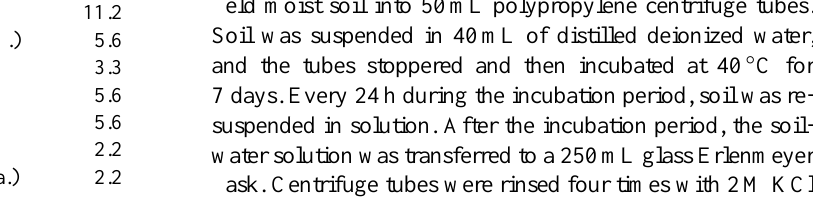
Table 2. Species and rate of application of ground cover hy- droseeded in 2008 at the Arch–Birch River mine in Webster County, West Virginia. Species Rate Birdsfoot trefoil ( Lotus corniculatus L.) Kobe lespedeza ( Kummerowia striata Maxim.) Ladino clover ( Trifolium repens